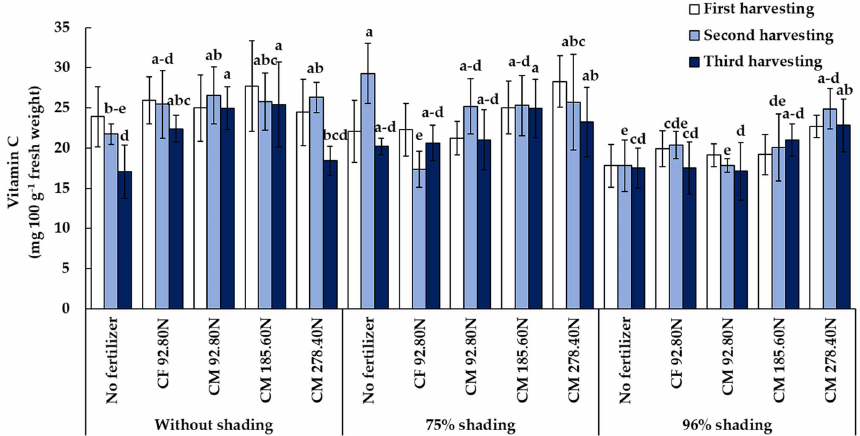
Figure 5. Vitamin C in fiddleheads of vegetable fern grown under different shading and fertilizer application treatments at each harvesting time. Values are means with standard deviations ( n = 4). The different letters above the bars indicate statistically significant differences by Duncan’s multiple range tests ( p < 0.05) within each harvesting